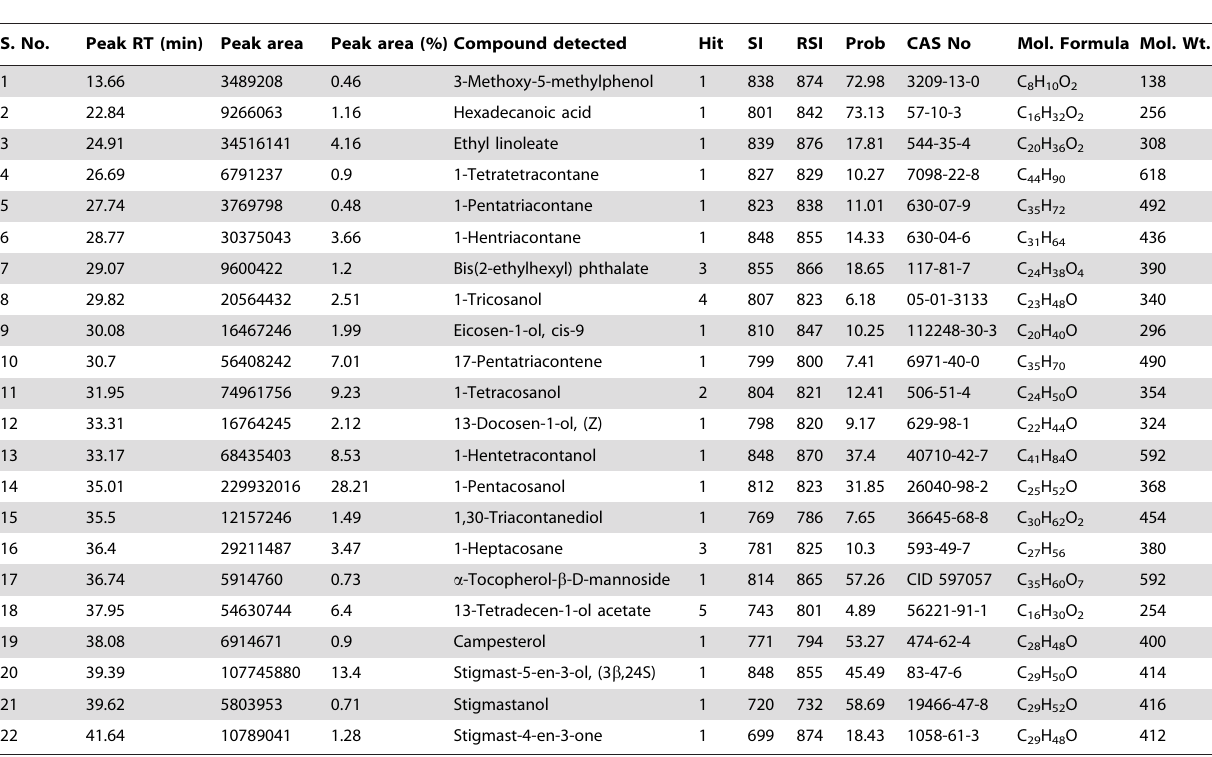
Table 1. Phyto-chemotypes identified in the n-hexane root extract of R. imbricata by GC/MS.